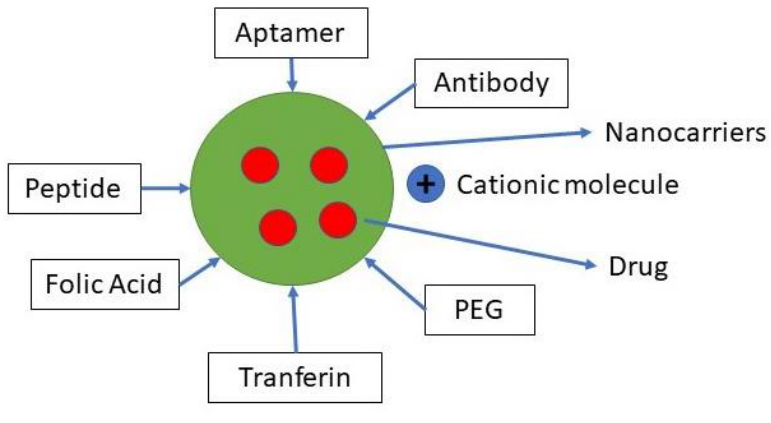
Figure 3. Ligan for active targeting.